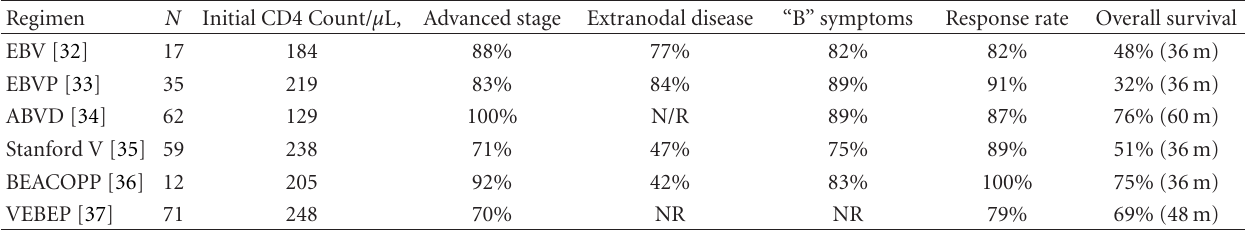
Table 1: Prospective studies of combination chemotherapy for HIV-HL in the cART era.